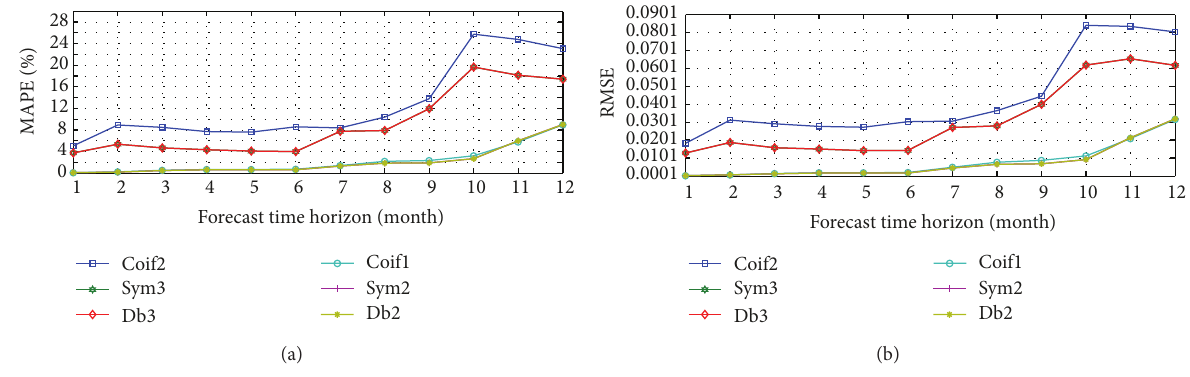
Figure 5: Forecasting horizon for WAR